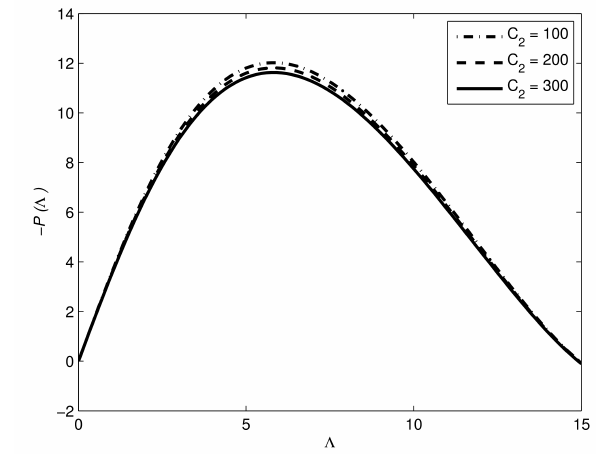
Figure 10: Effect of ζ on F ( Λ ) keeping η = 0.2 , C 1 = C 2 = C 3 = 50 , Pr = 6.8 , Br = 1 and Re = 2950